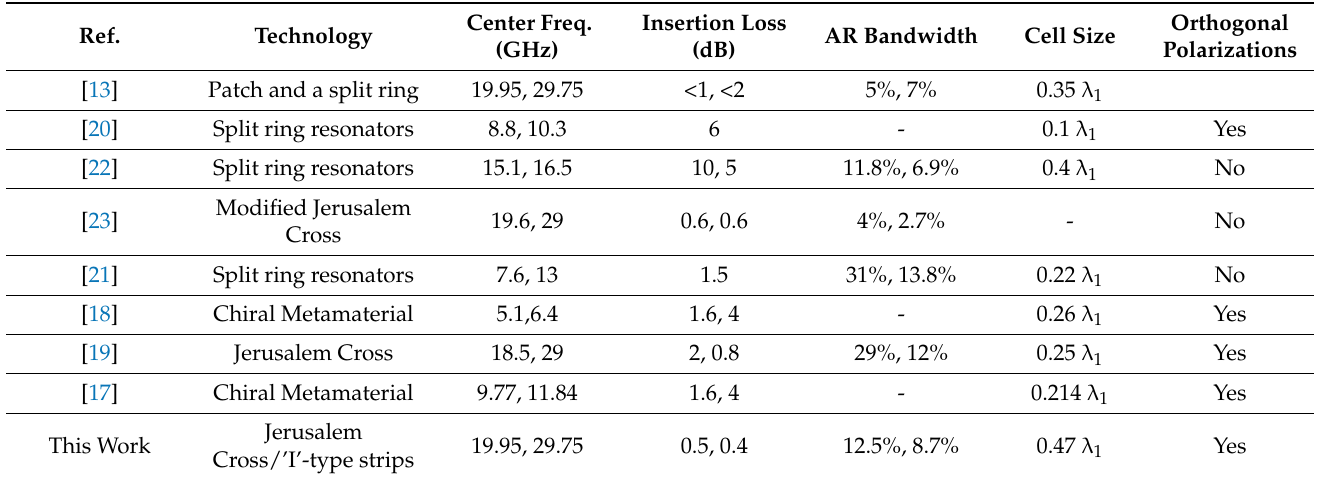
Table 1. Performances comparison among dual-band